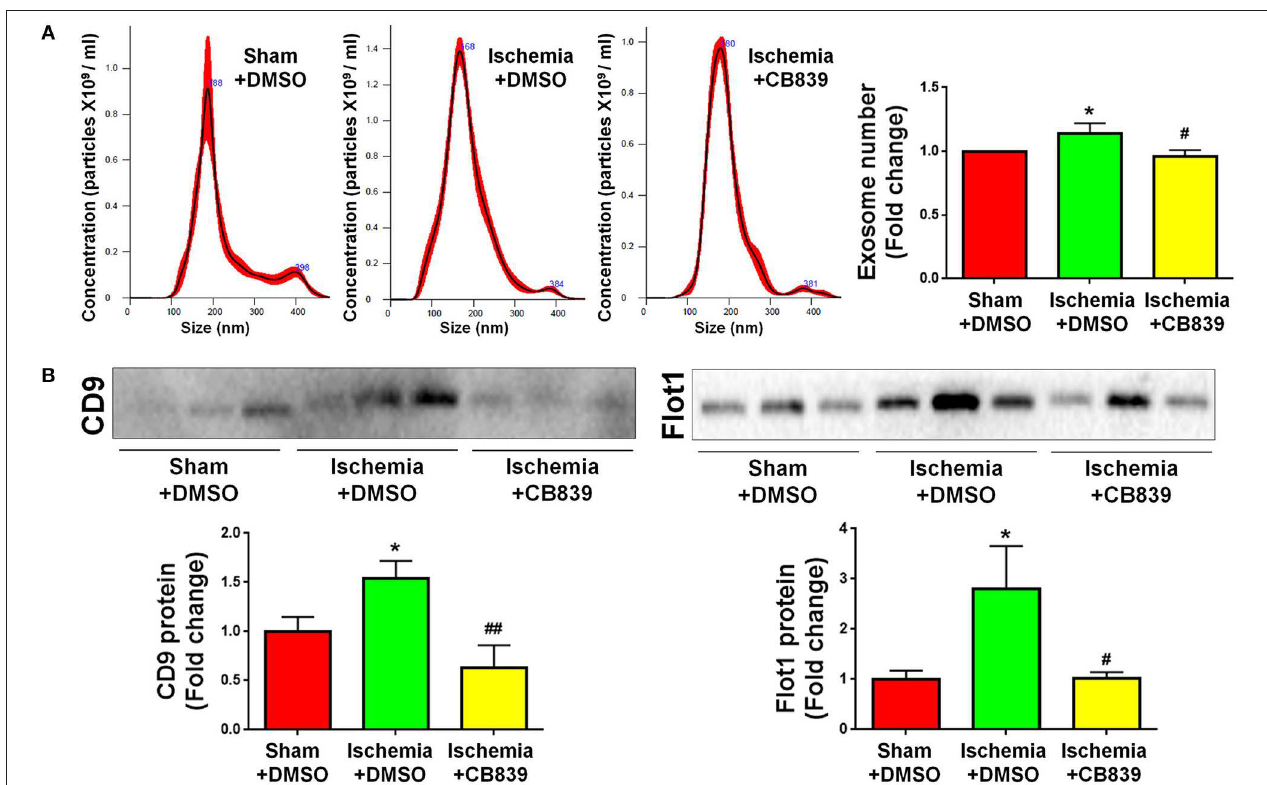
FIGURE 5 | GLS1 inhibition by CB839 suppresses exosome release. Seven days post either DMSO or CB839 administration, exosomes were collected from ischemic and sham brain extracellular spaces for NTA (A) and western blot (B) analyses. (A) The concentration of exosome suspension was determined by NTA. (B) Representative immunoblots of CD9 and Flot1 were shown along with quantifications of protein expression levels. Data were presented as fold change compared with those in sham rat brains. Error bars denote s.d. from triplicate measurements. * p < 0.05 by two-tailed t -test ( n = 9). # p < 0.05 and ## p < 0.01 vs. the ischemia with DMSO treatment group by two-tailed t -test ( n =